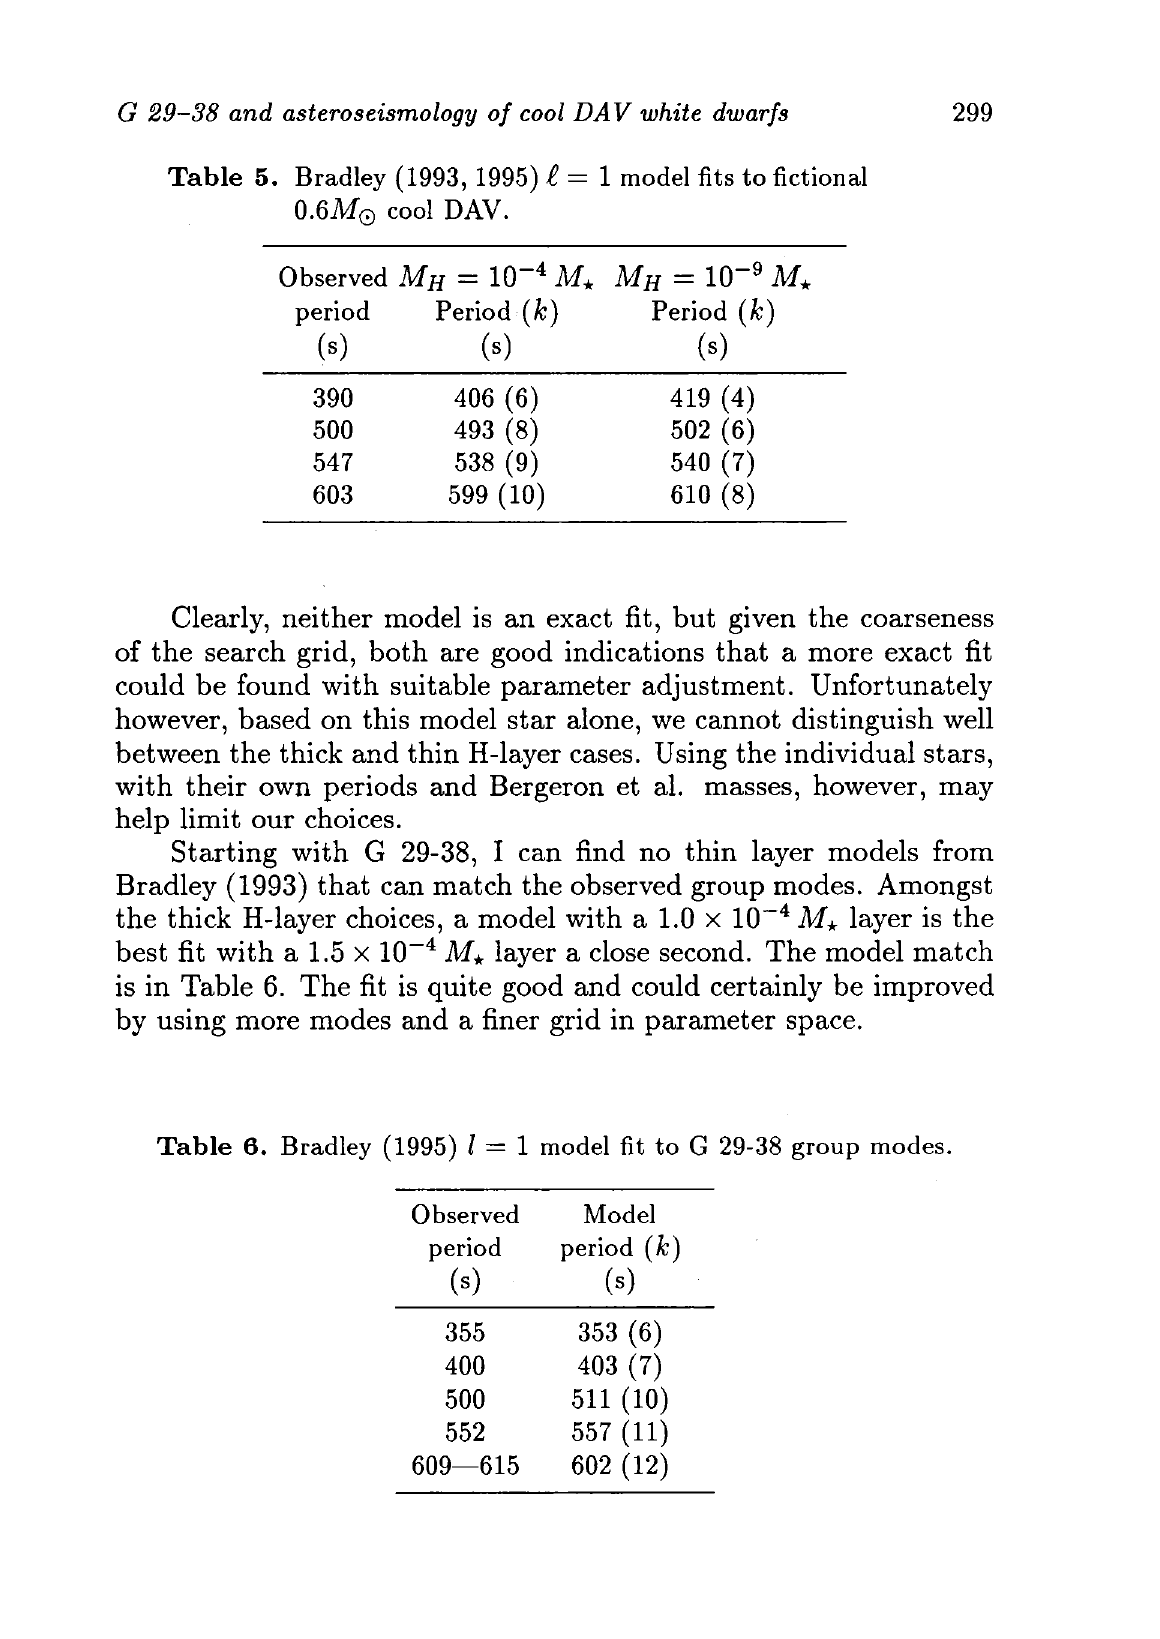
Table 6. Bradley (1995) I = 1 model fit to G 29-38 group